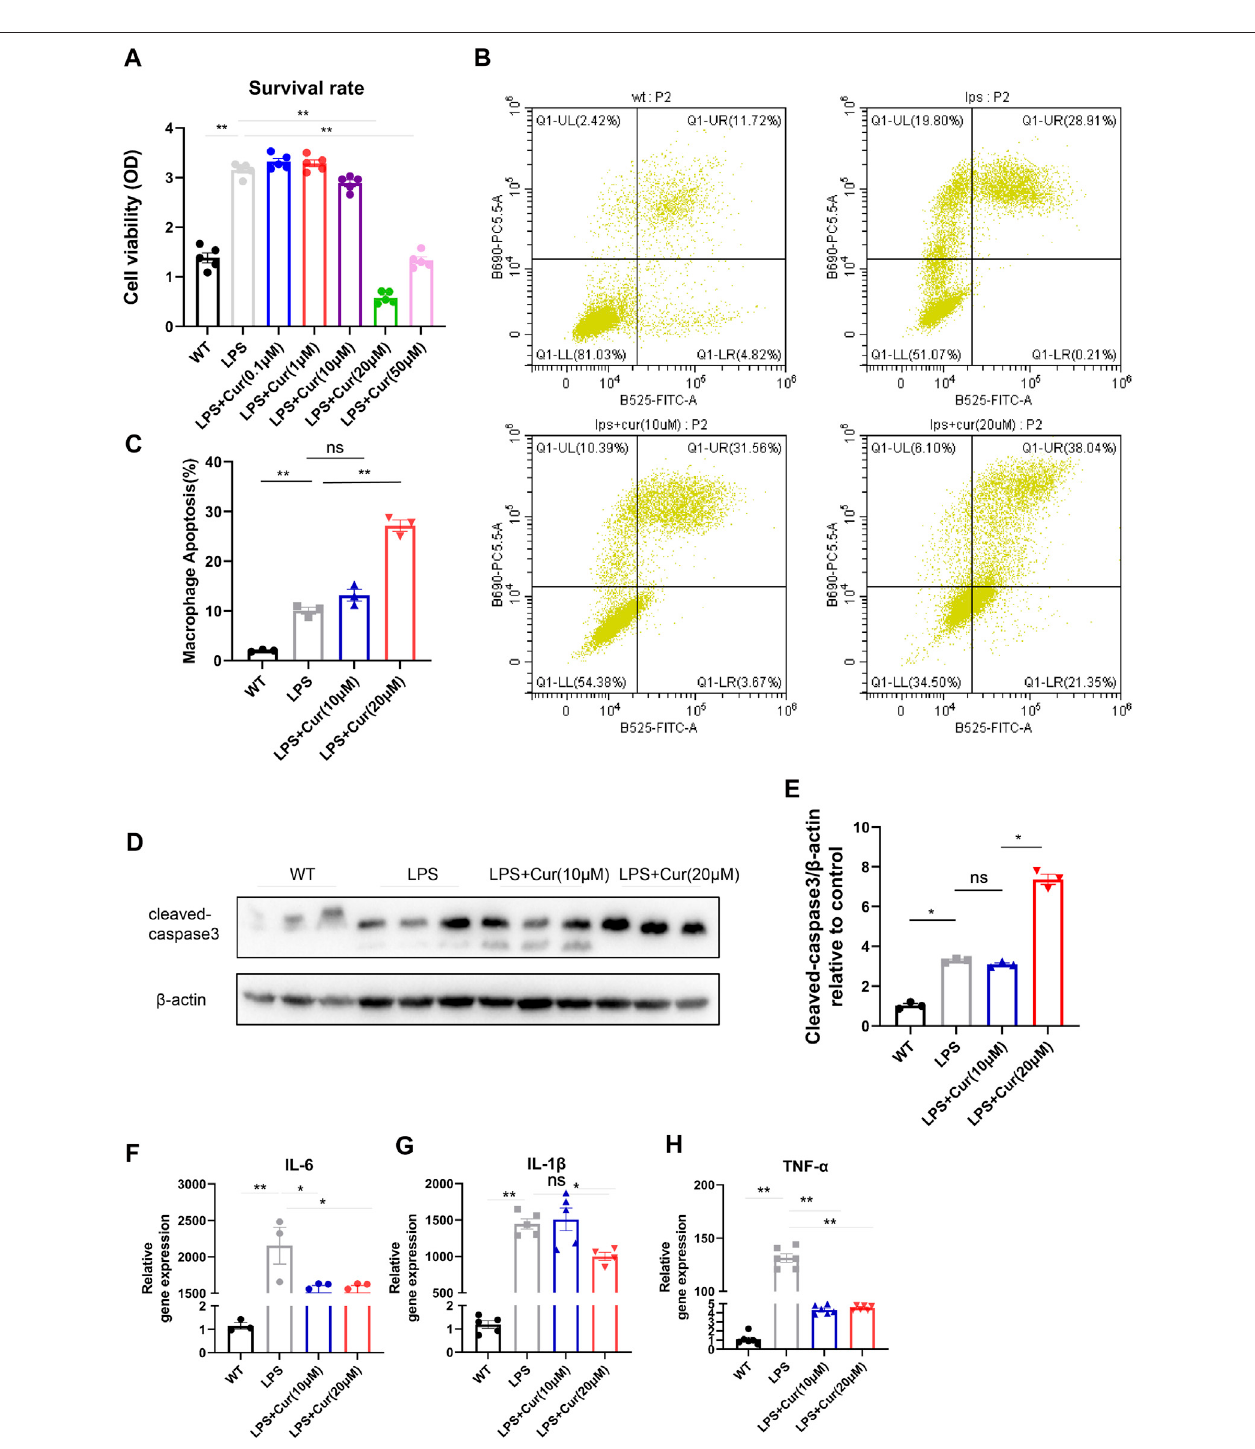
FIGURE3| Curcuminpromotes macrophage apoptosis invitro and restrain pro-in fl ammatorycytokine secretio (A). Macrophage survivalwasidenti fi edby CCK-8 analysisinrespectivegroups(WT,LPS,LPS+Cur0.1,1,10,20,and50 μ M) (B-C) .Macrophageapoptosiswasdeterminedby fl owcytometryinrespectivegroups(WT, LPS, LPS+Cur 10and 20 μ M),summarydataaredisplayed in (C)(D – E). Pro-apoptoticproteincleaved-caspasethree identi fi cationbywesternblotwereconducted in respective groups (WT, LPS, LPS + Cur 10 μ M and LPS + Cur 20 μ M), original bands are displayed in (D) and summary data were illustrated in (E) (F – H). Pro- in fl ammatorycytokinedetectedbyqPCRfromcellineachgroup(WT,LPS,LPS+Cur10 μ MandLPS+Cur20 μ M),summarydataofIL-6wasplottedin (F) ,IL-1bin (G) and TNF- α in (H) . Results are mean with SEM, NS (cid:1) no signi fi cance between groups, * p < 0.05, ** p < 0.01.